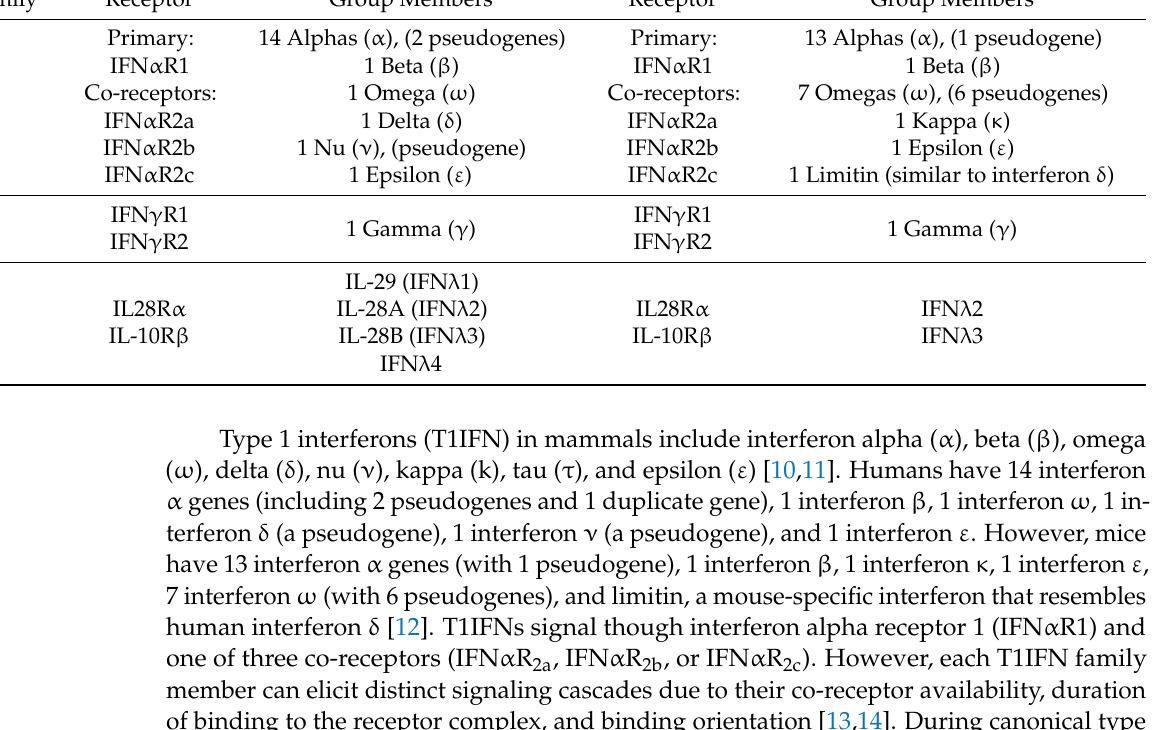
Table 1. Classification of type 1, 2, and 3 interferon members and interferon receptors in humans and mice. Human Mouse Interferon